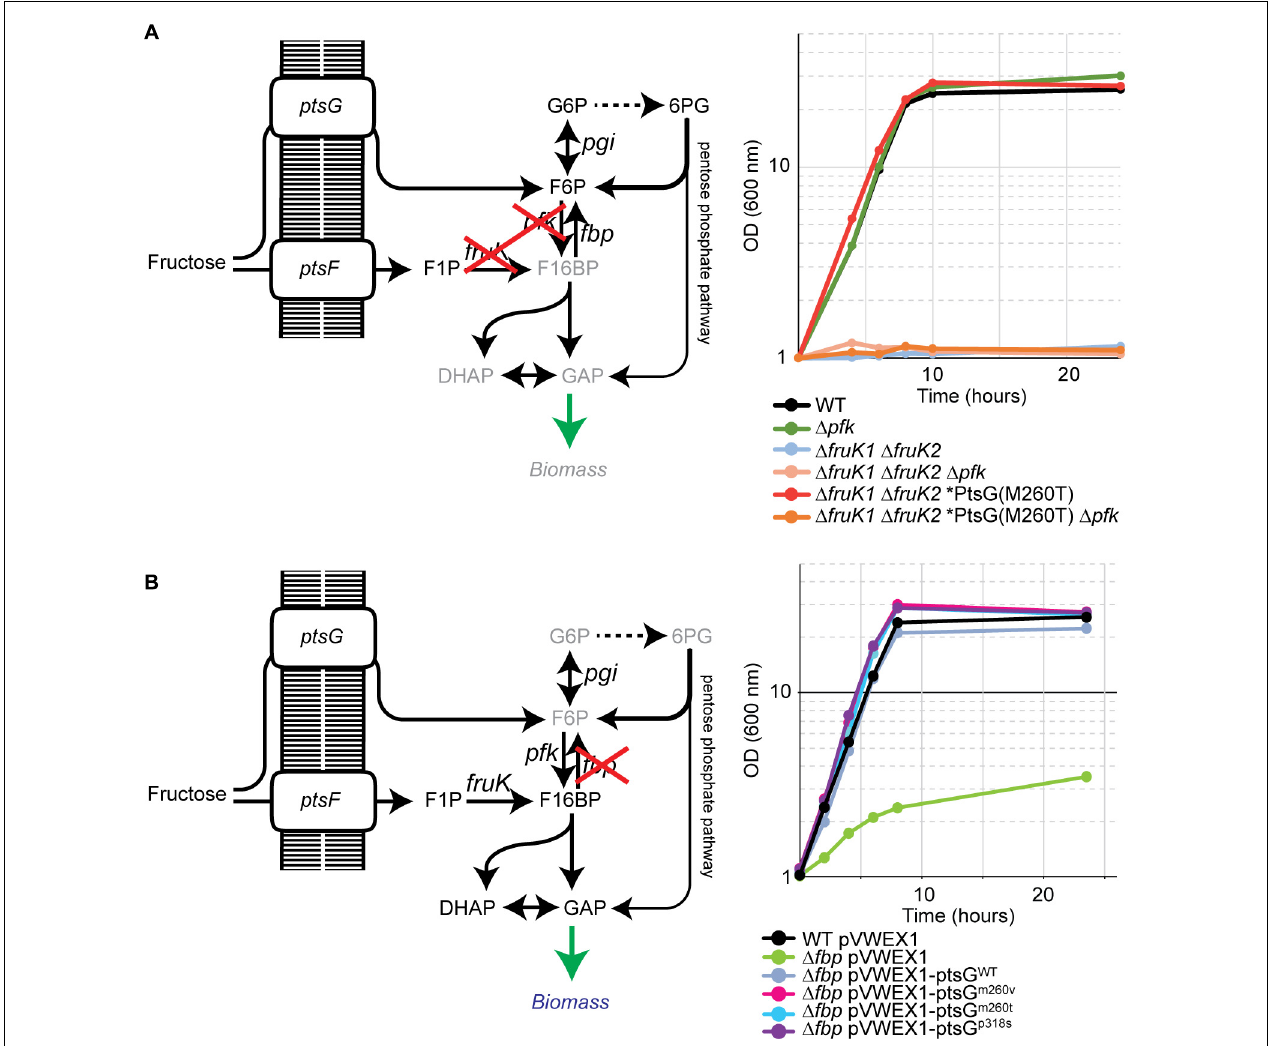
FIGURE 4 | Genetic elucidation of fructose phosphorylation to fructose 6-P by PtsG. (A) Deletion of 6-phosphofruktokinase ( (cid:49) pfk ) in (cid:49) fruK1 (cid:49) fruK2 fructose mutant abolishes growth. (B) Overexpression of PtsG variants improve growth of a fructose 1,6-bisphosphatase deletion strain ( (cid:49) fbp ). Data represent one of two individual cultivations that differed < 5%.